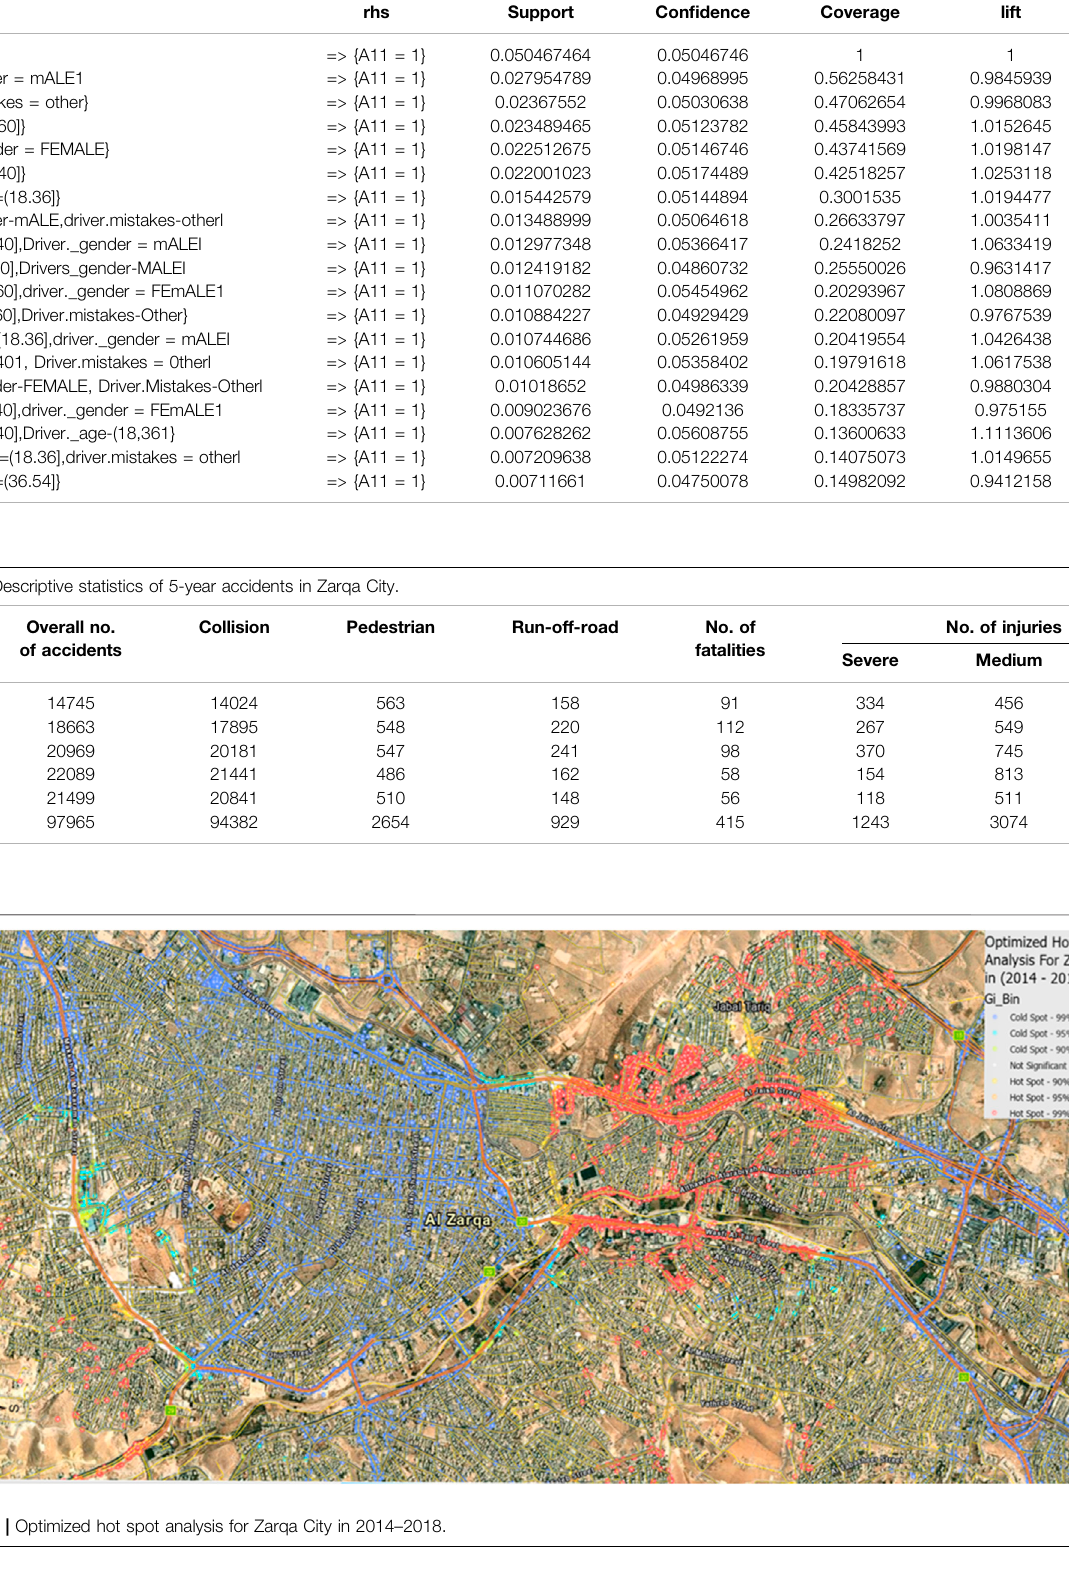
Frontiers in Built Environment |